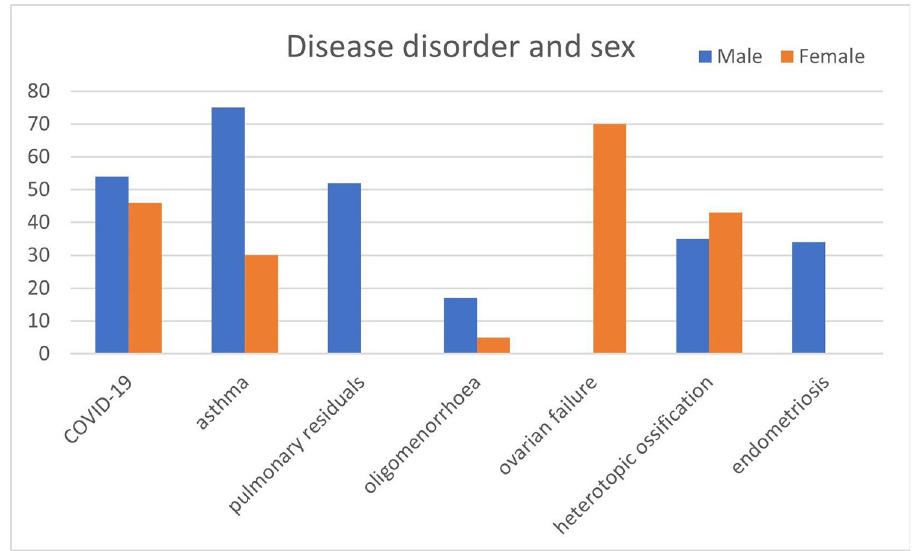
Fig 6. Distribution of disease disorders among male and female groups.